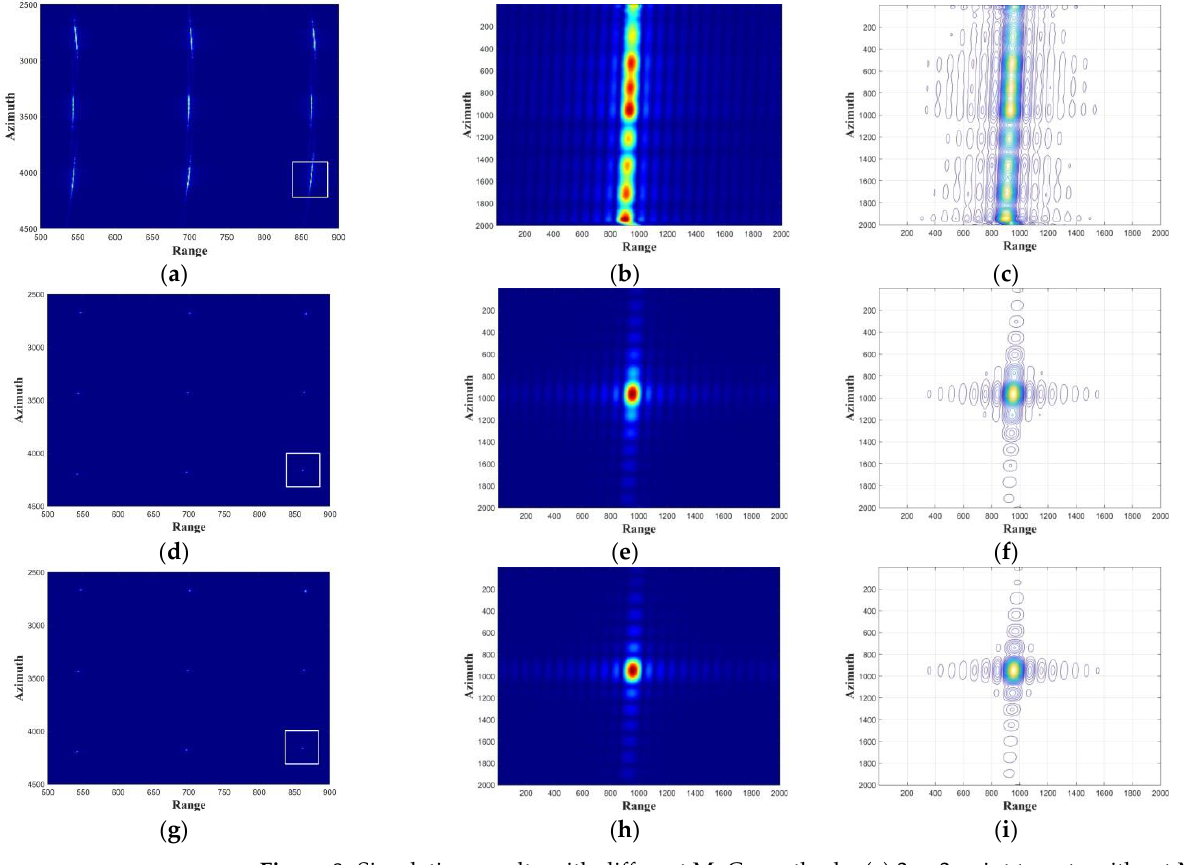
Figure 8. Simulation results with different MoCo methods. ( a ) 3 × 3 point targets without MoCo. ( b ) Enlarged rectangle area of ( a ). ( c ) Slice of ( b ). ( d ) 3 × 3 point targets with NB MoCo. ( e ) Enlarged rectangle area of ( d ). ( f ) Slice of ( e ). ( g ) 3 × 3 point targets with LOS MoCo. ( h ) Enlarged rectangle area of ( g ). ( i ) Slice of ( h